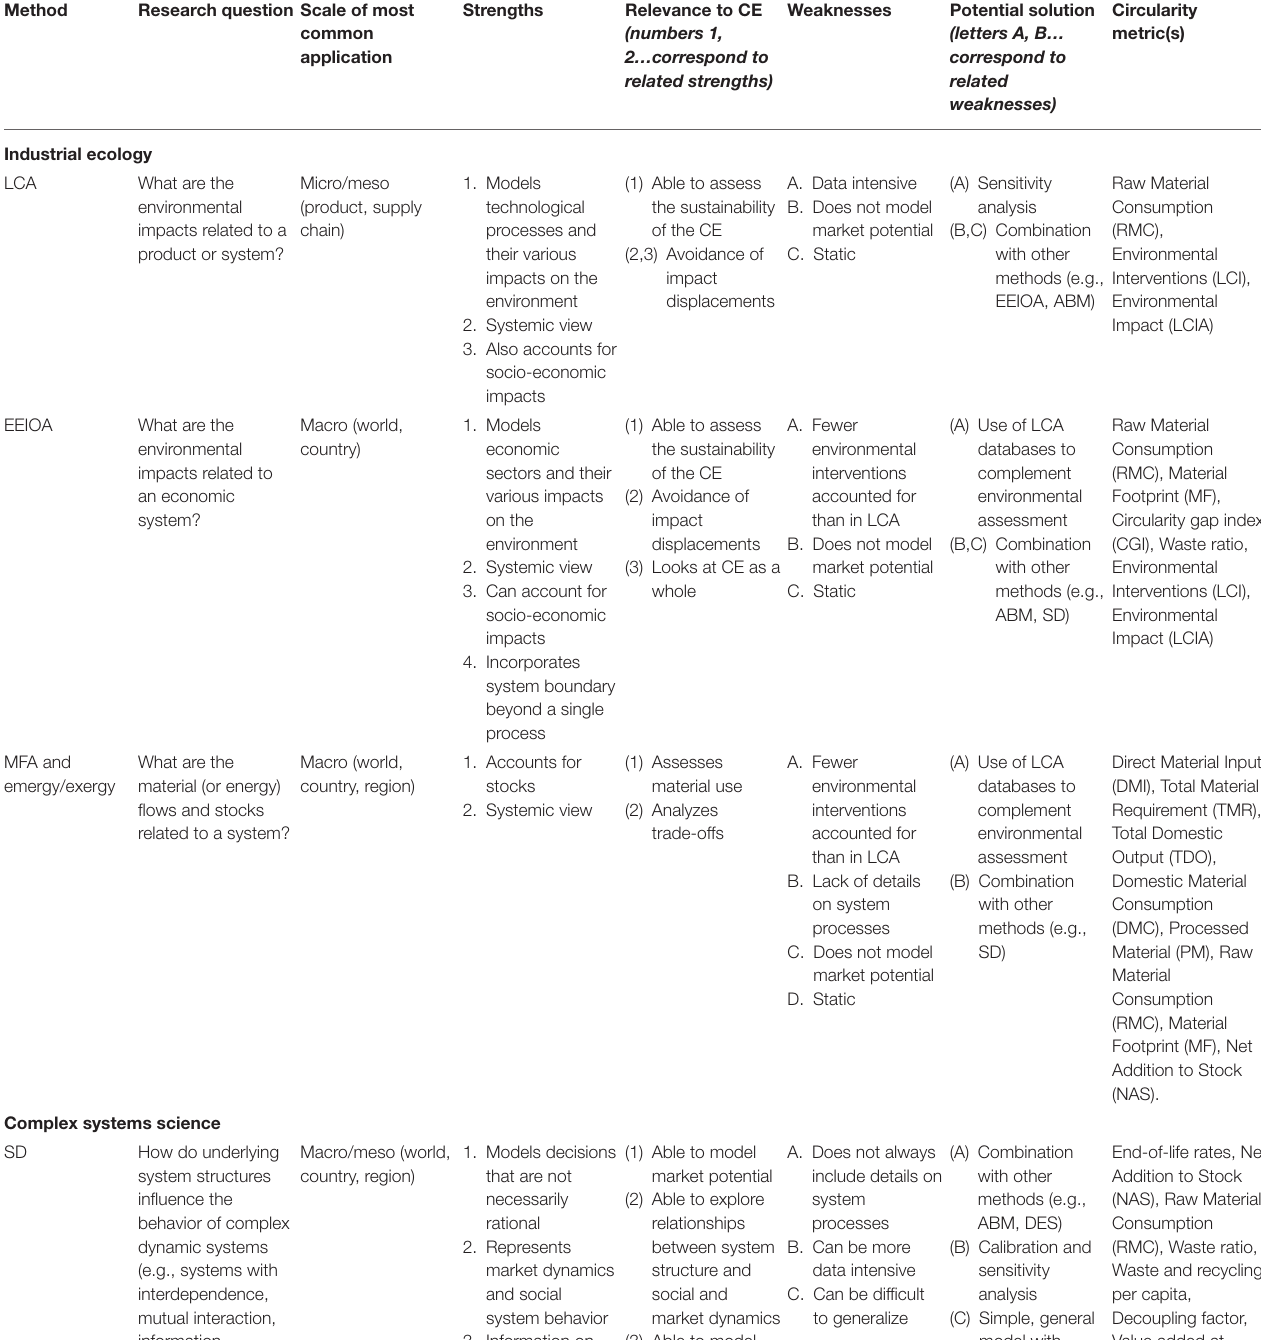
TABLE 2 | Strengths and weaknesses of reviewed methods with respect to CE—the elements of the table (e.g., weaknesses) may not be exhaustive in order to stay concise and focus the analysis on CE.